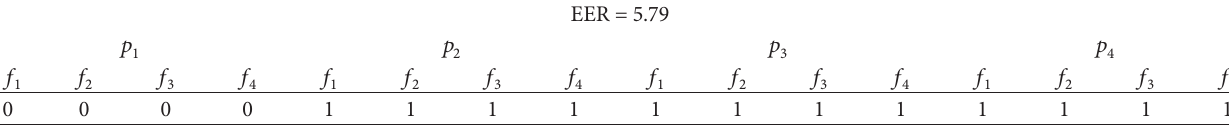
Table 11: Equal error rate with 4 images removed (combination number